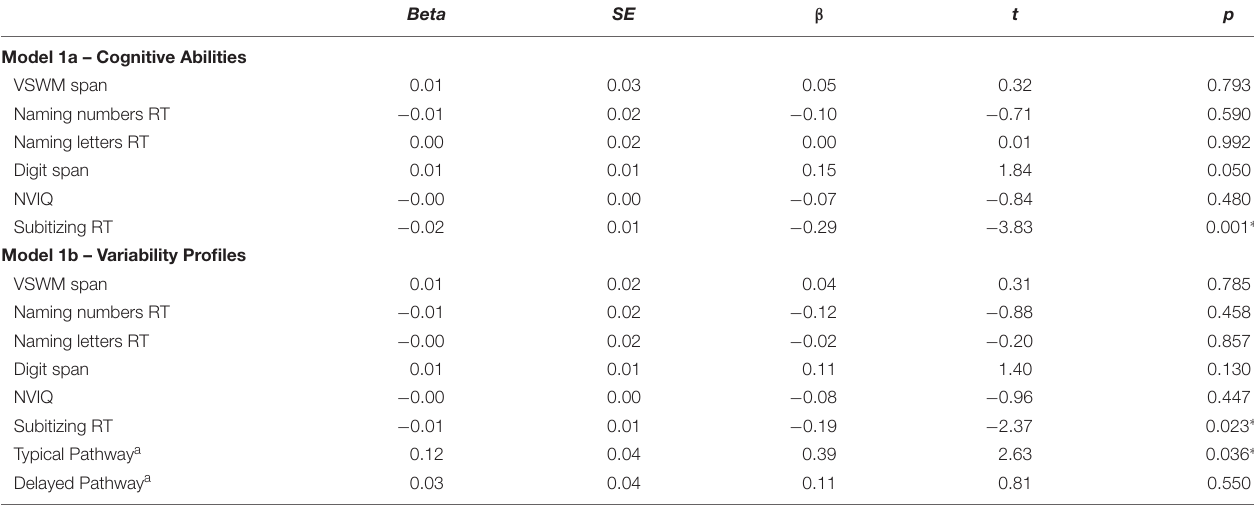
TABLE 5 | Model 1: Linear regressions predicting DDA PRT success.